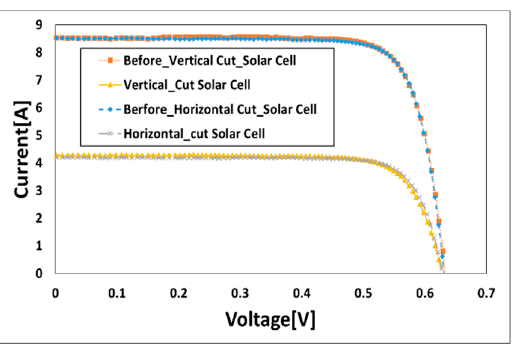
Figure 6. Current-voltage characteristic curve for a 50% vertically and 50% horizontally cut c-Si solar cell.